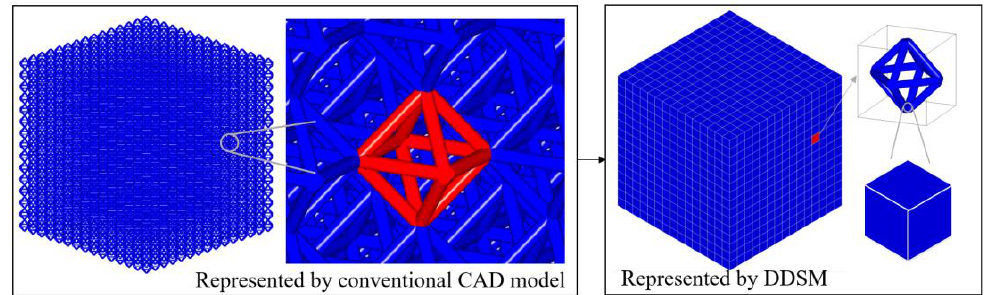
Figure 14. A 3 30 30 30 mm   cubic domain consisting of octahedral unit cells.